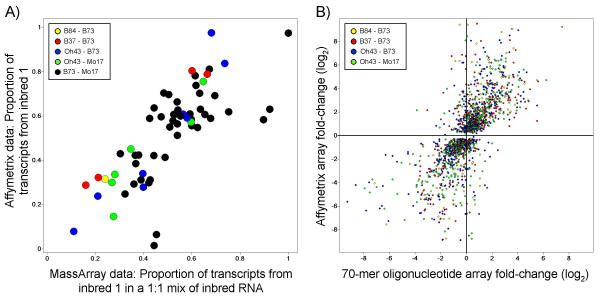
Validation of differential expression using MassArray and 70-mer platforms. The magnitude of differential expression between inbred lines based on the Affymetrix data was compared to the magnitude of differential expression detected using the MassArray platform and 70-mer microarray platform. The subset of the genes identified as differentially expressed on the Affymetrix platform (FDR < 0.05, and additional quality control filters; see Methods) was used for these analyses. The color coding of the data points indicates the inbred genotype comparison. (A) The same inbred RNA samples used for Affymetrix microarray analyses were mixed in a pairwise 1:1 ratio and subjected to MassArray relative allelic quantification [25]. The correlation between the MassArray proportions and the proportions calculated from the Affymetrix dataset (inbred 1 signal divided by the sum of the two inbred signals) are shown. Each spot represents the proportion of one allele per inbred-inbred comparison. The B73 and Mo17 sequence SNPs were used to design the assays, thus this comparison is most highly represented in this analysis. (B) Many genes that were determined to be differentially expressed in the Affymetrix dataset were also present on the 70-mer microarray platform. The correlation of the inbred expression fold-differences on the 70-mer oligonucleotide microarray and the Affymetrix microarray are shown. Each spot represents the fold-differences of one gene per inbred-inbred comparison. The 70-mer microarray data validated the directionality of the Affymetrix microarray patterns in 84–91% of the differentially expressed profiles (see main text).